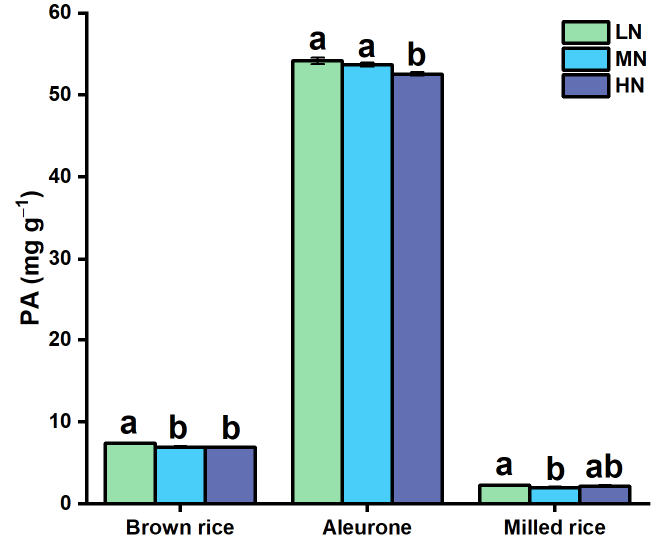
Figure 3. Effect of N levels on phytic acid (PA) concentration in different rice grain fractions (brown rice, milled rice, and aleurone) (XS110 of 2016 in hydroponic culture). LN: low nitrogen level; MN: medium nitrogen level; HN: high nitrogen level; PA: phytic acid. Bars indicate the mean ± SE. Different letters for every 3 N levels (LN, MH, HN) denoted significant differences according to one-way ANOVA analysis followed by Tukey’s multiple comparison test.